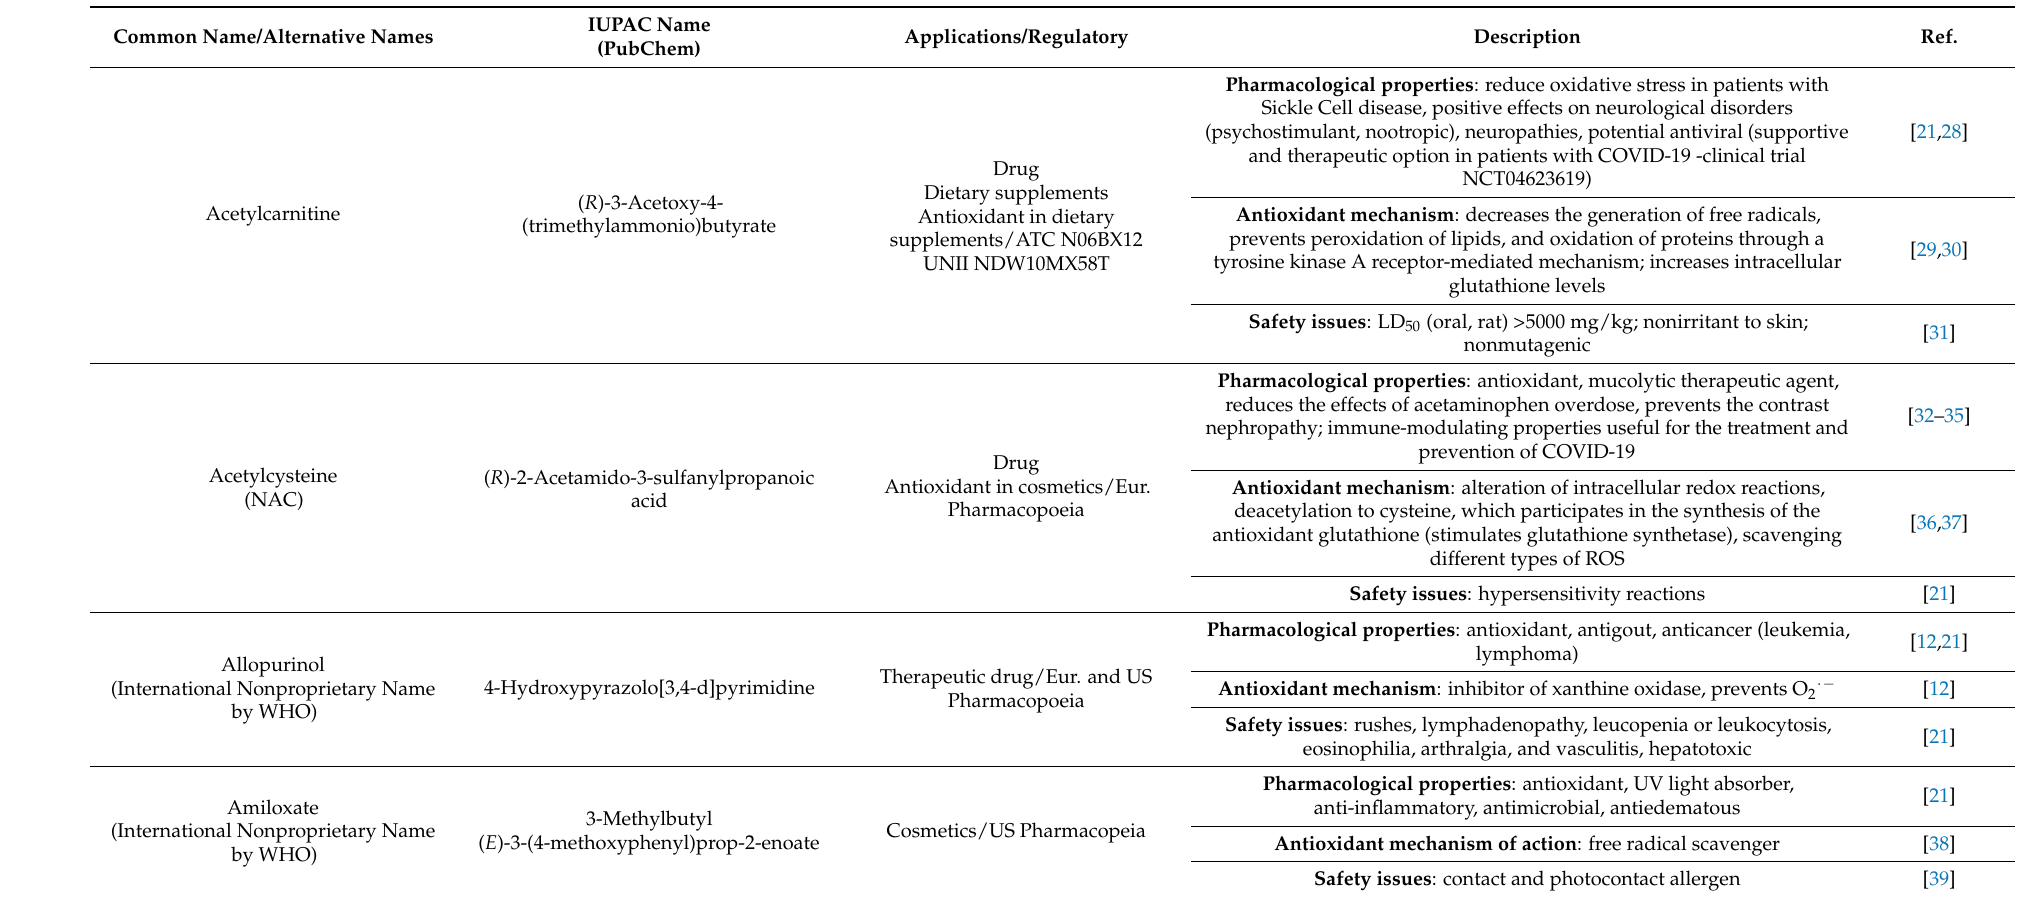
Table 2. List of 32 principal approved synthetic low-molecular-weight antioxidants used as technological additives, dietary supplements or therapeutic agents (alphabetical